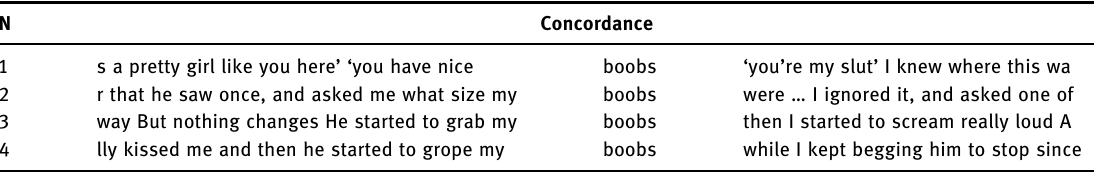
Table 45: Concordance lines for boobs